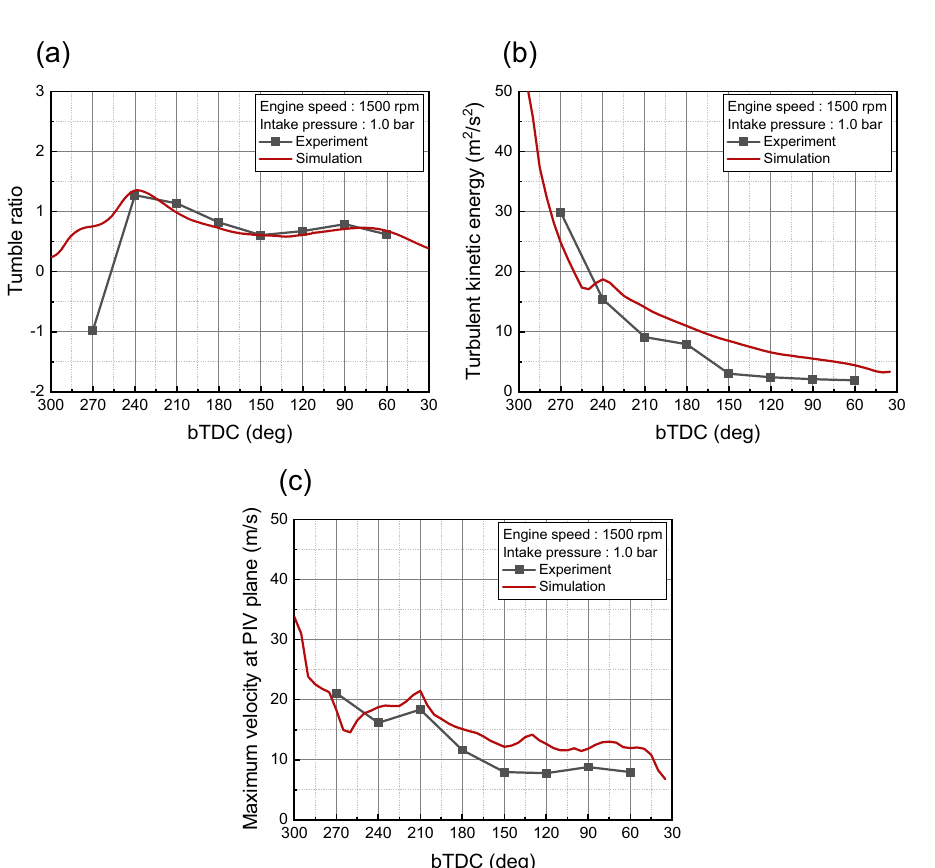
Figure 9. Comparison quantitative data between experiment and simulation: ( a ) tumble ratio, ( b ) turbulent kinetic energy, ( c ) maximum